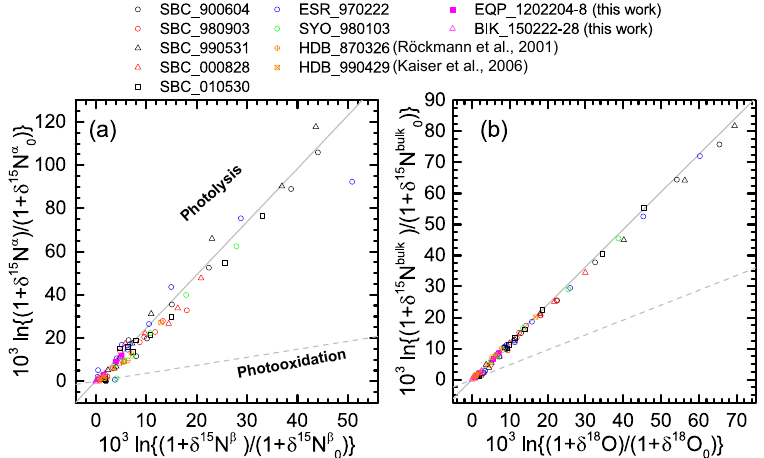
Figure 5. Correlations between δ 15 N β and δ 15 N α of N 2 O (a) and between δ 18 O and δ 15 N bulk of N 2 O (b) . The δ values are normalized as noted in the text. Grey solid and broken lines show slopes obtained respectively from laboratory broadband photolysis experiments (Kaiser et al., 2002b, 2003) and photooxidation experiments (Kaiser et al., 2002a; Toyoda et al.,